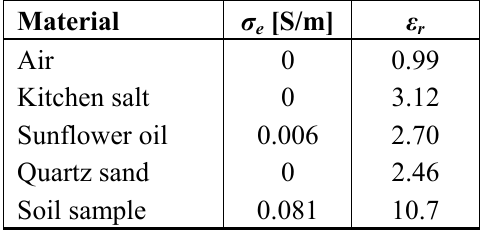
and effective conductivity σ r